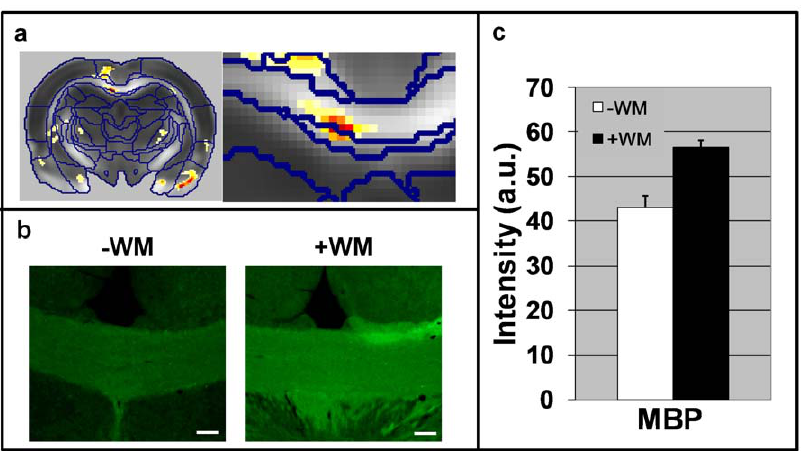
Figure 4. Histological analysis of the corpus callosum in representative mice from group L. ( a ) Statistical parametric maps of interaction between scan time and group in a representative slice that includes the corpus callosum (CC). An enlargement of this region is shown on the right. ( b ) Immunohistochemical staining ( 6 10 magnification) of the CC for MBP. Note the increase in MBP immuno-reactivity in the CC after completion of the water maze task. The white bar at the bottom right corner represents 100 m m. ( c ) Quantification of the immunoreactivity (staining intensity) in the CC. Asterisk denotes P , 0.05.